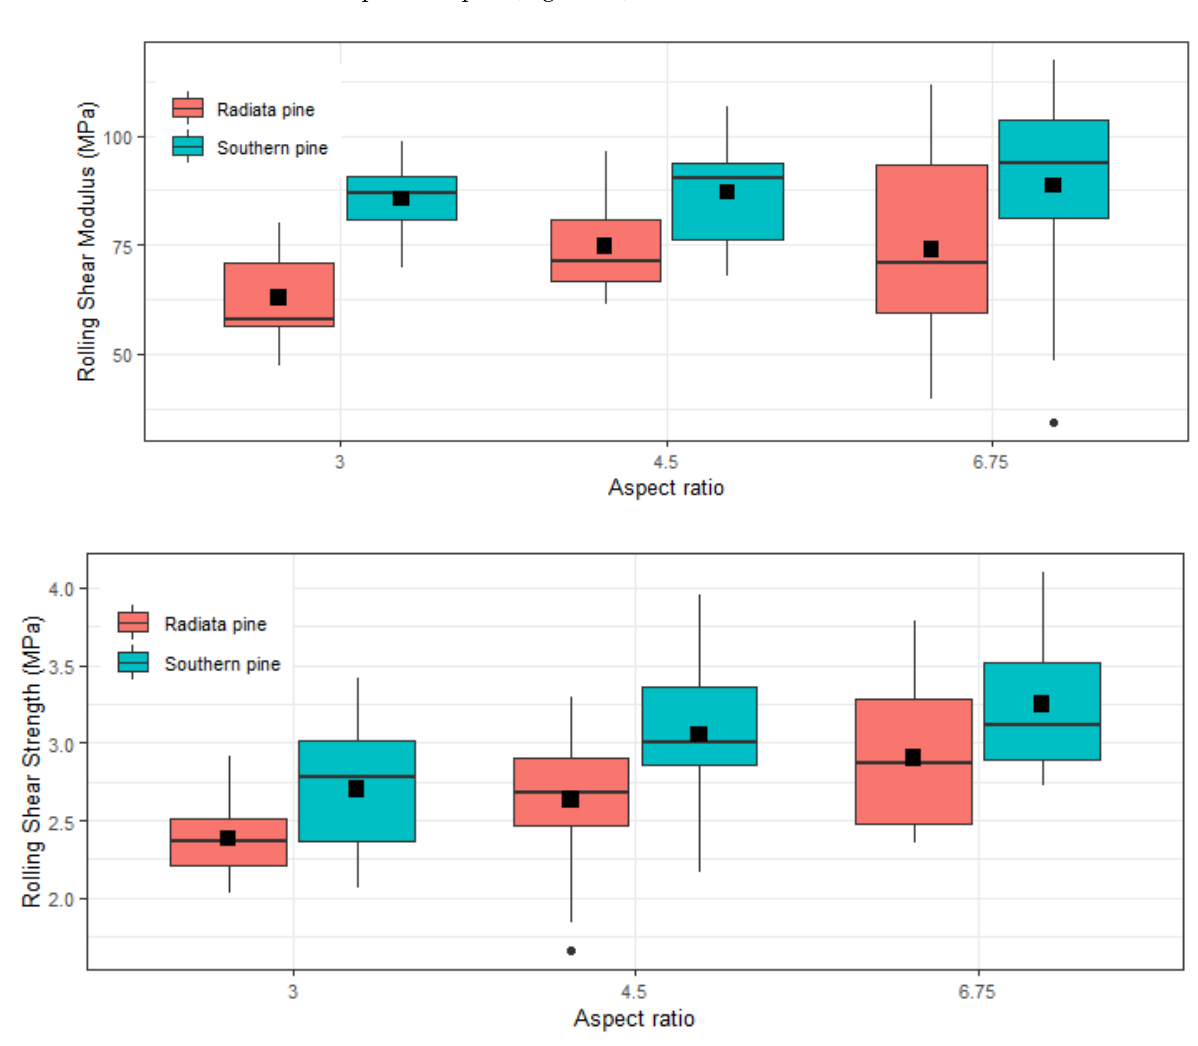
Figure 10. Effect of aspect ratio on the mean values of RS modulus ( top ) and strength ( bottom ). Table 7. Effect of AR on the RS properties (southern